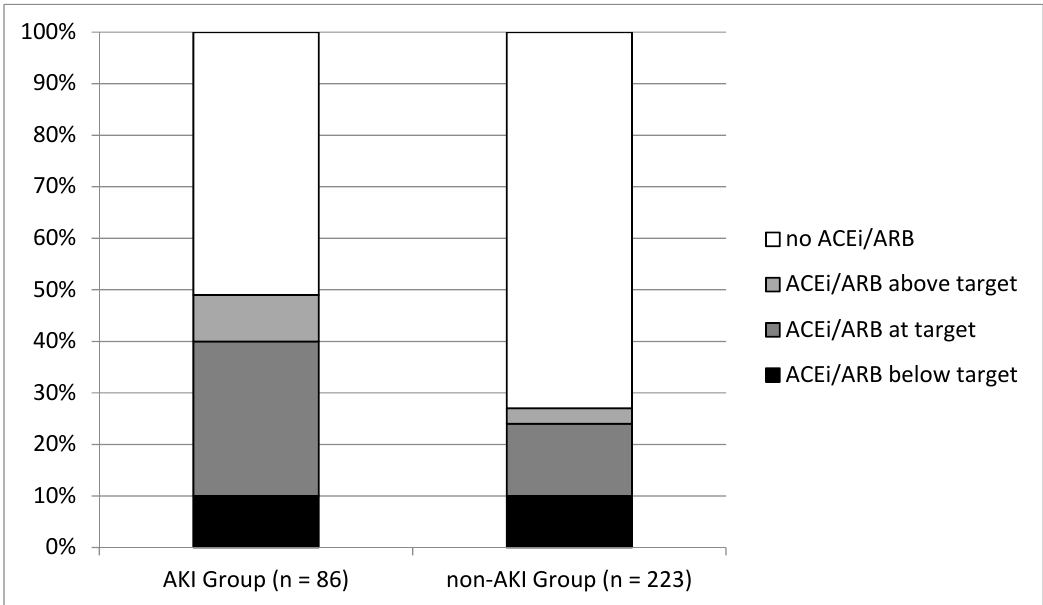
Figure 1. Percentage of patients on ACEi/ARB at above target, target and below target dosage in the AKI Group and in the non-AKI Group.